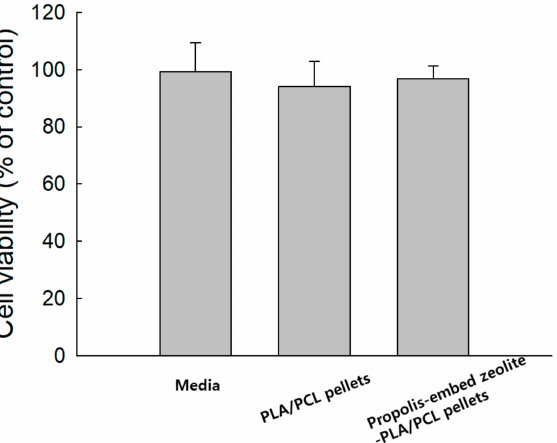
Figure 7. The effect of empty PLA/PCL composite pellets or propolis-embedded zeolite/PLA-PCL nanocomposite pellets on the viability of HaCaT